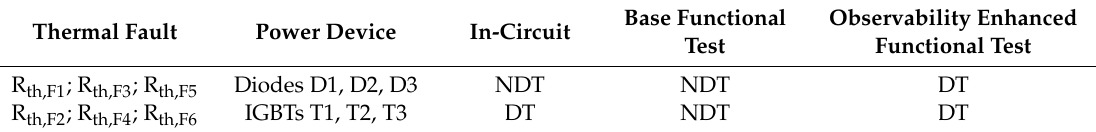
Table 5. Test approach